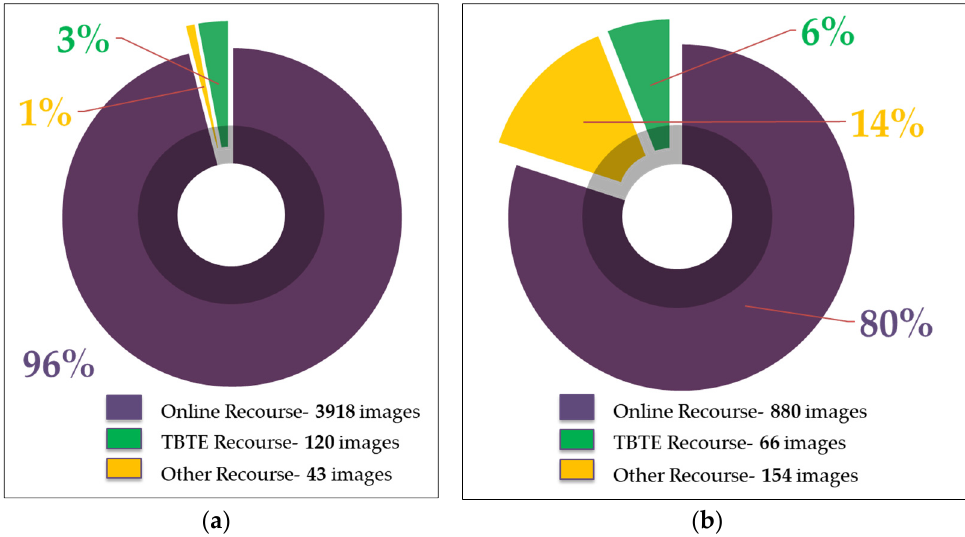
Figure 2. Size of dataset. ( a ) Crack dataset. ( b ) Spalling dataset.